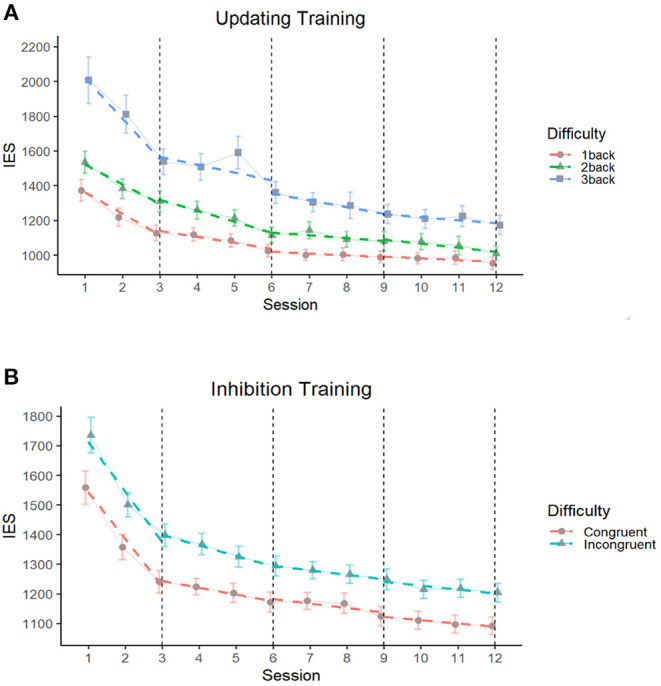
Comparison of performances (IES) by difficulty level throughout updating (A) and inhibition (B) training programs segmented by groups of three sessions. The Inverse Efficiency Score (IES) corresponds to the mean reaction time from each training session divided by the proportion of accuracy. Solid lines correspond to the average performance and colored dashed lines correspond to the regression slopes segmented into four segments of three training sessions representing the four time segments of training. The dashed black vertical line depicts the end of each training segment, where the slopes are differentiated. The error bars depict the SEM.